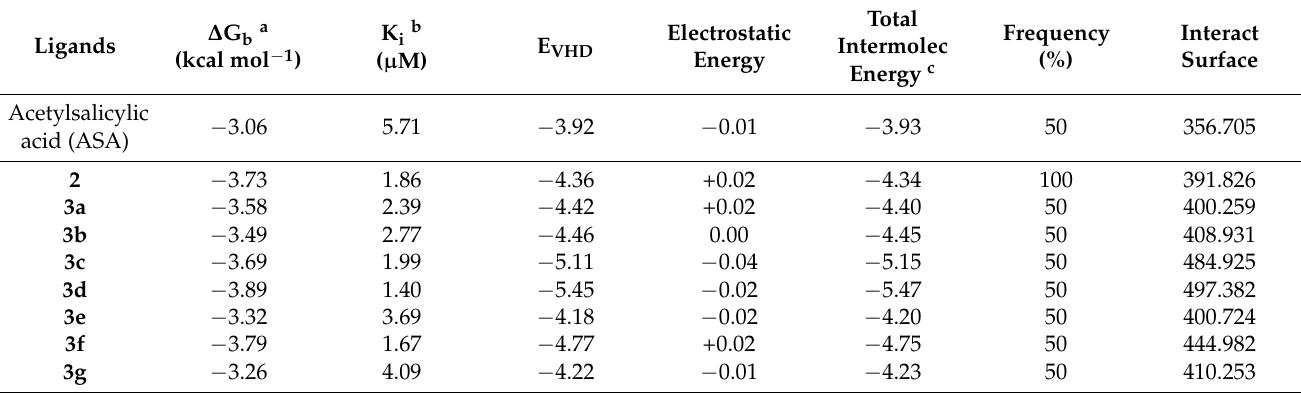
Table 5. Results of the docking of compounds 2 , and 3a – g into COX-1.